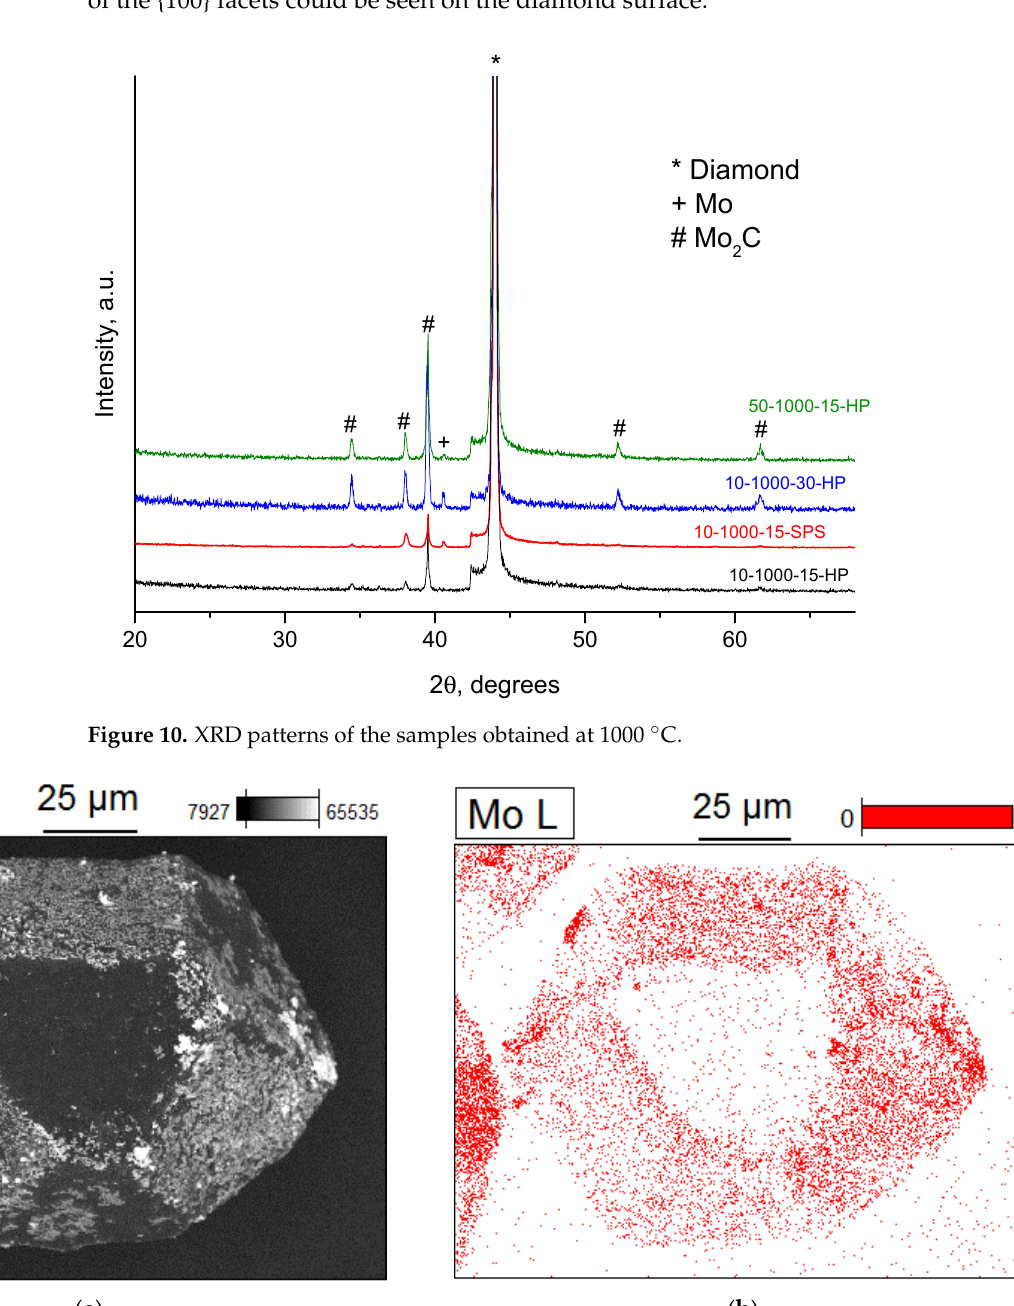
Figure 11. Scanning electron microscopy images ( a ) and elemental maps ( b ) of 10-1000-15-HP: a single coated diamond crystal, molybdenum-rich areas are red.